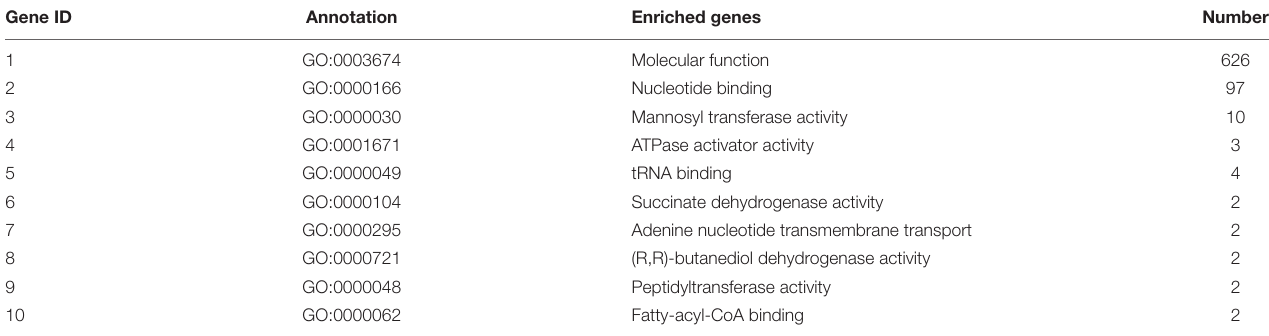
TABLE 8 | Top 10 important enriched GO terms of B. maydis for molecular functions differentially expressed in inoculated resistant and susceptible plants.